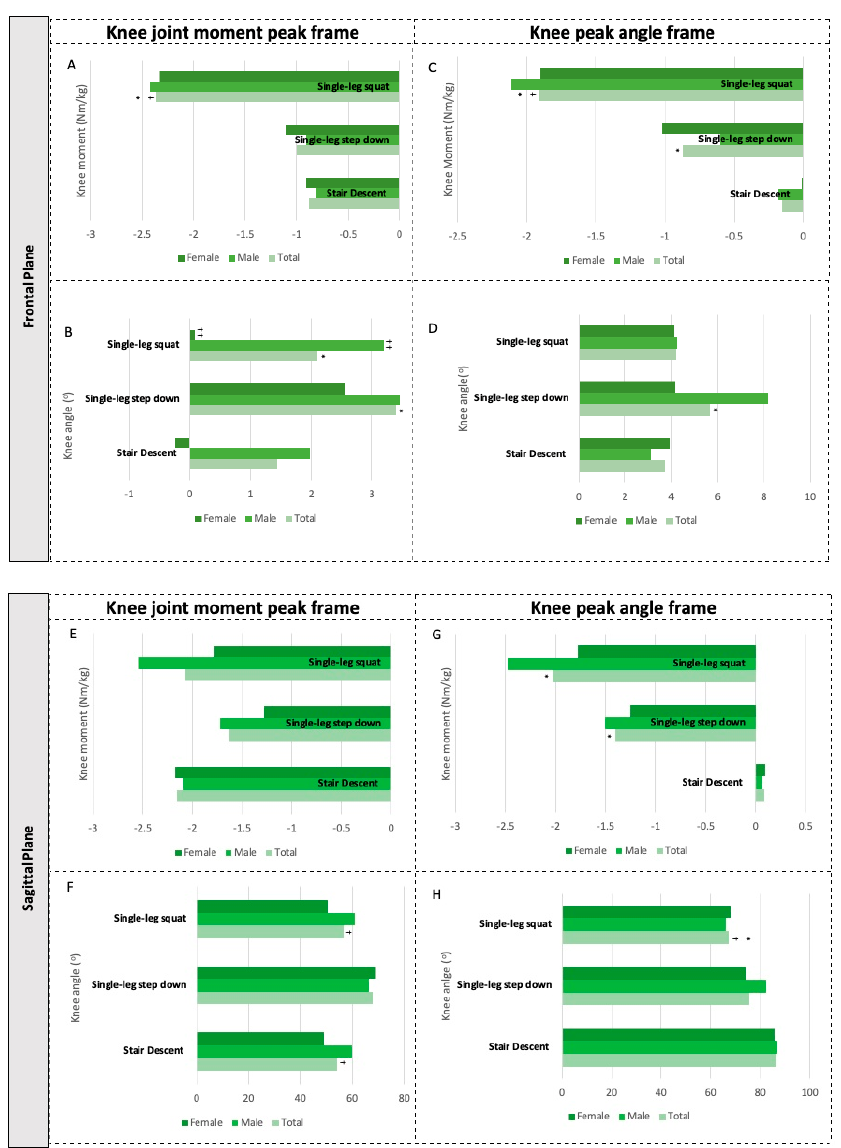
Figure 3. Knee kinetics and kinematics during single-leg weight-bearing tasks of asymptomatic young people ( n = 30) and stratified by sex (15 females, 15 males): median in the moment of occurrence of the articular peak moment ( A , B , E , F ) and the angular peak of the knee ( C , D , G , H ) in both the frontal and sagittal plane during stair descent, single-leg step down and single-leg squat. Subfigures are displayed according to the plane and the frame: the knee moments and angle at the frontal plane from the knee joint knee peak frame ( A , B ) and from the knee peak angle frame ( C , D ); the knee moments and angle at the sagittal plane from the knee joint knee peak frame ( E , F ) and from the knee peak angle frame ( G , H ). Note: Symbols represent in the frontal plane abduction/varus (+) and adduction/valgus ( − ) of the knee, and in the sagittal plane, flexion (+) extension ( − ) of the knee. * Different stair descent ( p < 0.05). † Different from single-leg step down ( p < 0.05). †† Sex difference ( p <